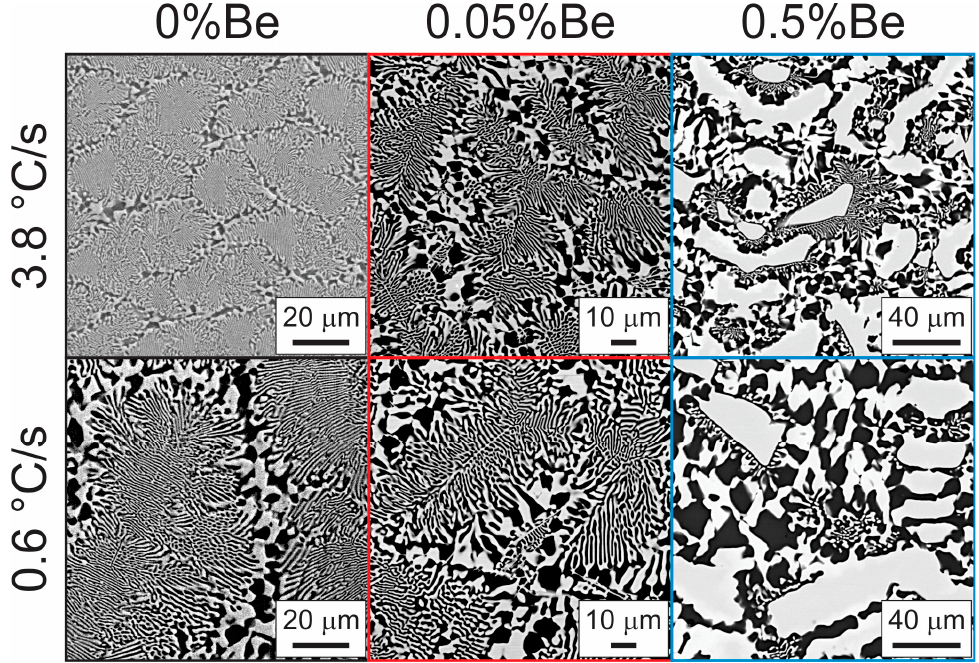
Figure 5. Transverse SEM images of Al-33 wt.%Cu, Al-33 wt.%Cu-0.05 wt.%Be and Al-33 wt.%Cu- 0.5 wt.%Be alloys under different cooling rates (3.8 °C/s and 0.6 °C/s).